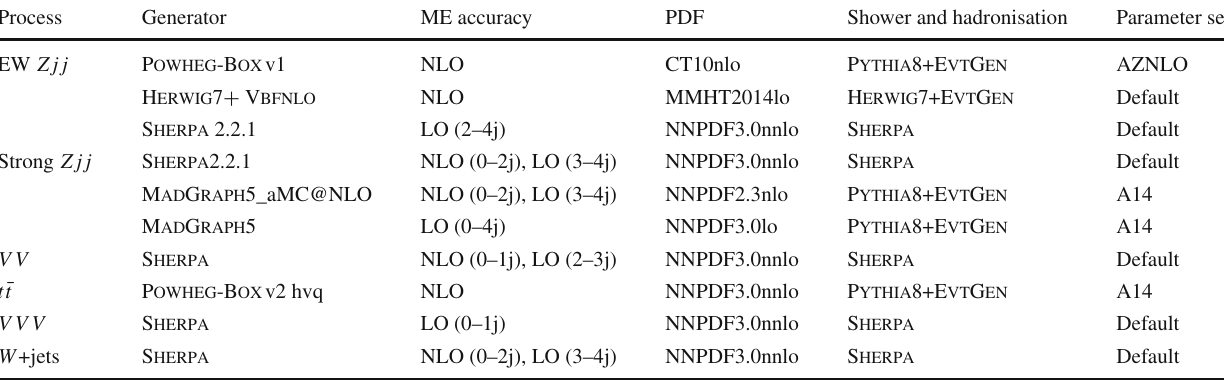
Table 1 Summary of generators used for simulation. The details and the corresponding references are provided in the body of the text. In the final column, ‘default’ refers to the default set of tuned parameters provided with the event generator